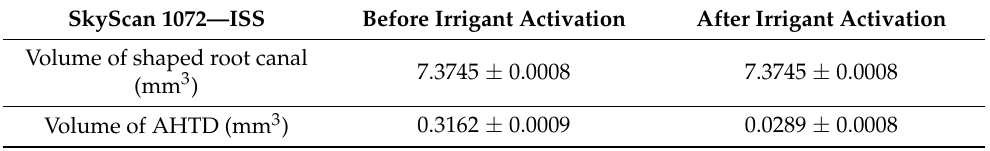
Table 2. EB group—volume (mm 3 ) of AHTD before and after the irrigant